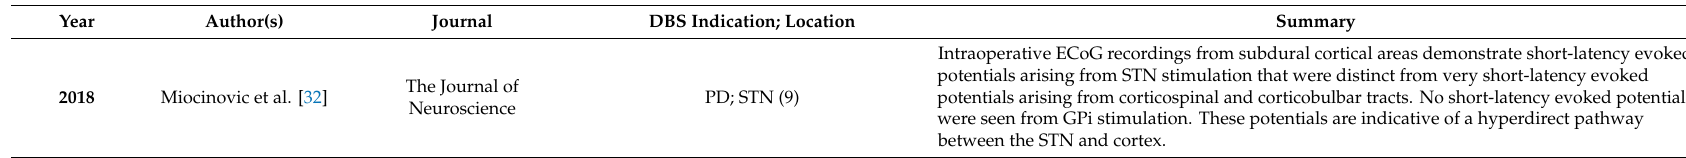
Table 1. ECOG: electrocorticography. DBS: deep brain stimulation, GPi: globus pallidus, PD: Parkinson’s disease, STN: subthalamic nucleus.